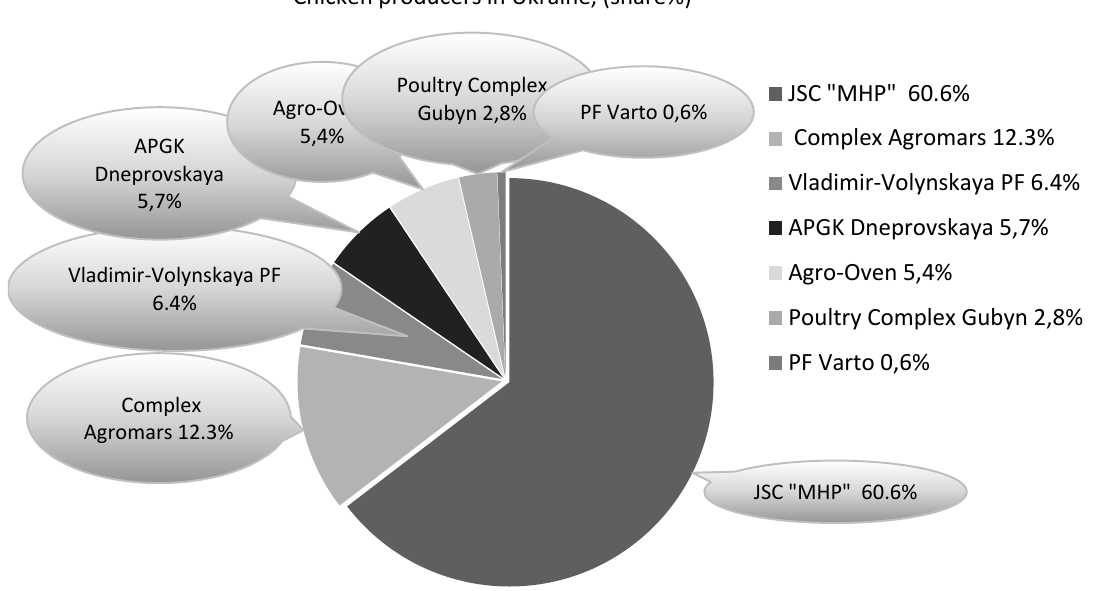
Figure 3. The structure of the poultry market in